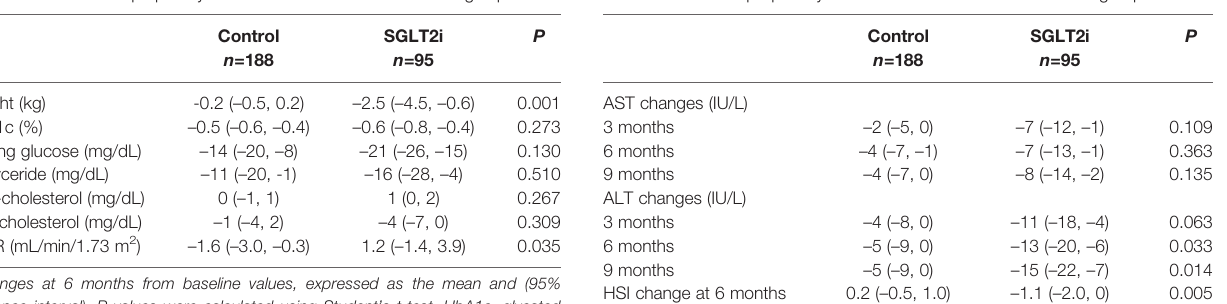
Original cohort